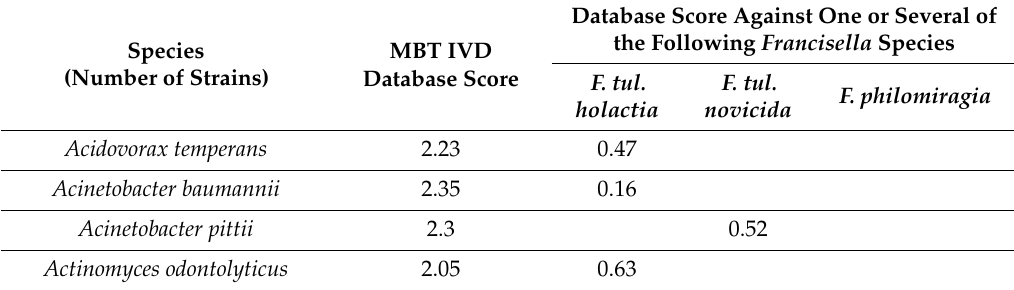
Table 3. Identification scores obtained with bacterial species other than Francisella sp. or the HACEK group, using the MBT IVD or FNRCT